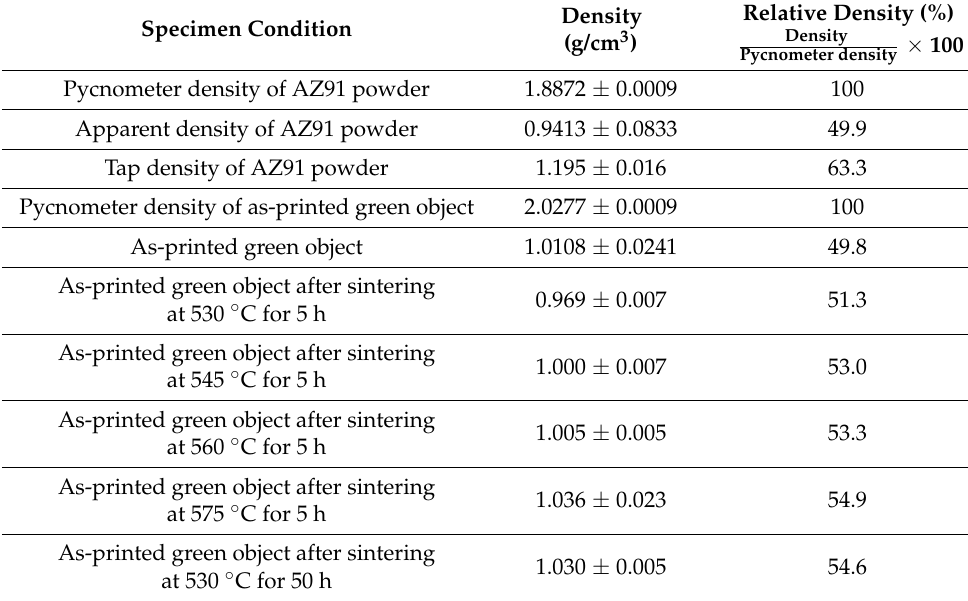
Table 2. Density of the AZ91 powder in various conditions (as-received, as-printed, and as-sintered). Specimen